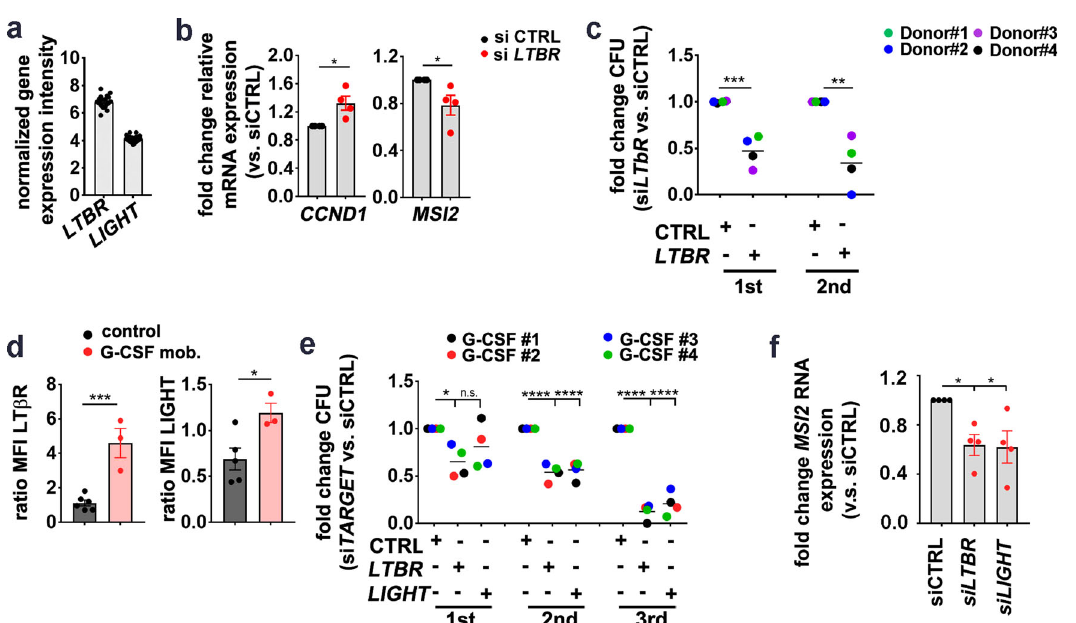
Fig. 7 LT β R signaling in human HSPCs. a mRNA expression intensity of LTBR and LIGHT in CD34 + cells from 27 healthy donors, analyzed in a publicly available microarray dataset (GSE32719). b Fold change of relative mRNA expression of indicated genes in HSPCs (CD45 int Lin − CD34 + ) from control samples, transfected with si LTBR (red) relative to HSPCs treated with siCTRL (black), n = 4, pooled for analysis from three independent experiments. c Fold-change CFU and re-plating of si LTBR - or siCTRL-transfected BM HSPCs ( n = 4, pooled for analysis from two independent experiments, shown as grand mean). d MFI (stain/isotype) of LT β R and LIGHT in BM HSPCs from control samples (black, n = 6) and G-CSF-mobilized PB HSPCs (red, n = 3). Data from fi ve independent experiments were pooled for analysis. e Fold-change CFU and re-plating of PB HSPCs from G-CSF-treated patients, transfected with indicated siRNA ( n = 4). Data are pooled for analysis from two independent experiments, shown as grand mean. f Fold change of MSI2 mRNA in HSPCs from G-CSF patients, transfected with si LTBR (red) or si LIGHT (red) relative to HSPCs treated with siCTRL (black) ( n = 4, pooled data for analysis from two independent experiments). Data are presented as mean ± SEM. Statistics: * P < 0.05, ** P < 0.01, *** P > 0.001 (two-tailed t test: b – d , and one-way ANOVA: e , f ). b : CCND1 p = 0.018, MSI2 p = 0.043; c : 1st p = 0.0007, 2nd p = 0.0028; d : LT β R p = 0.0007, LIGHT p = 0.030; e : 1st p = 0.04,